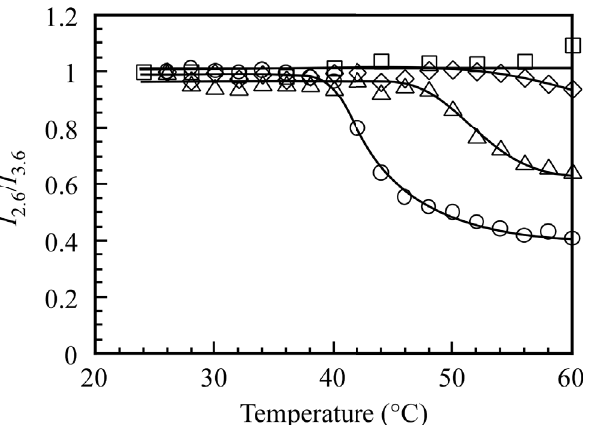
Figure 5. Peak intensity ratio of I PMPC -PDEA ( ○ ), PMPC 64 66 in D O containing 0.1 M NaCl at C 2